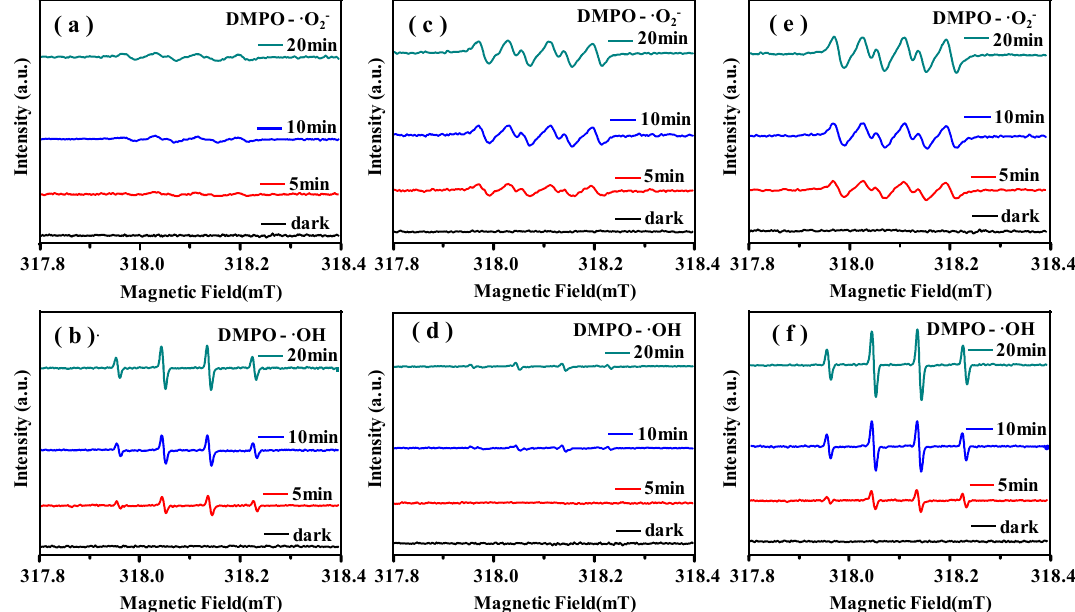
Figure 9. DMPO spin-trapping ESR spectra of photocatalysts in model fluid catalytic cracking (FCC) gasoline for ( a , b ) α -MoO 3 , ( c , d ) AgI, and ( e , f ) AAM-35 heterojunction under visible light irradiation ( λ > 420 nm), respectively.